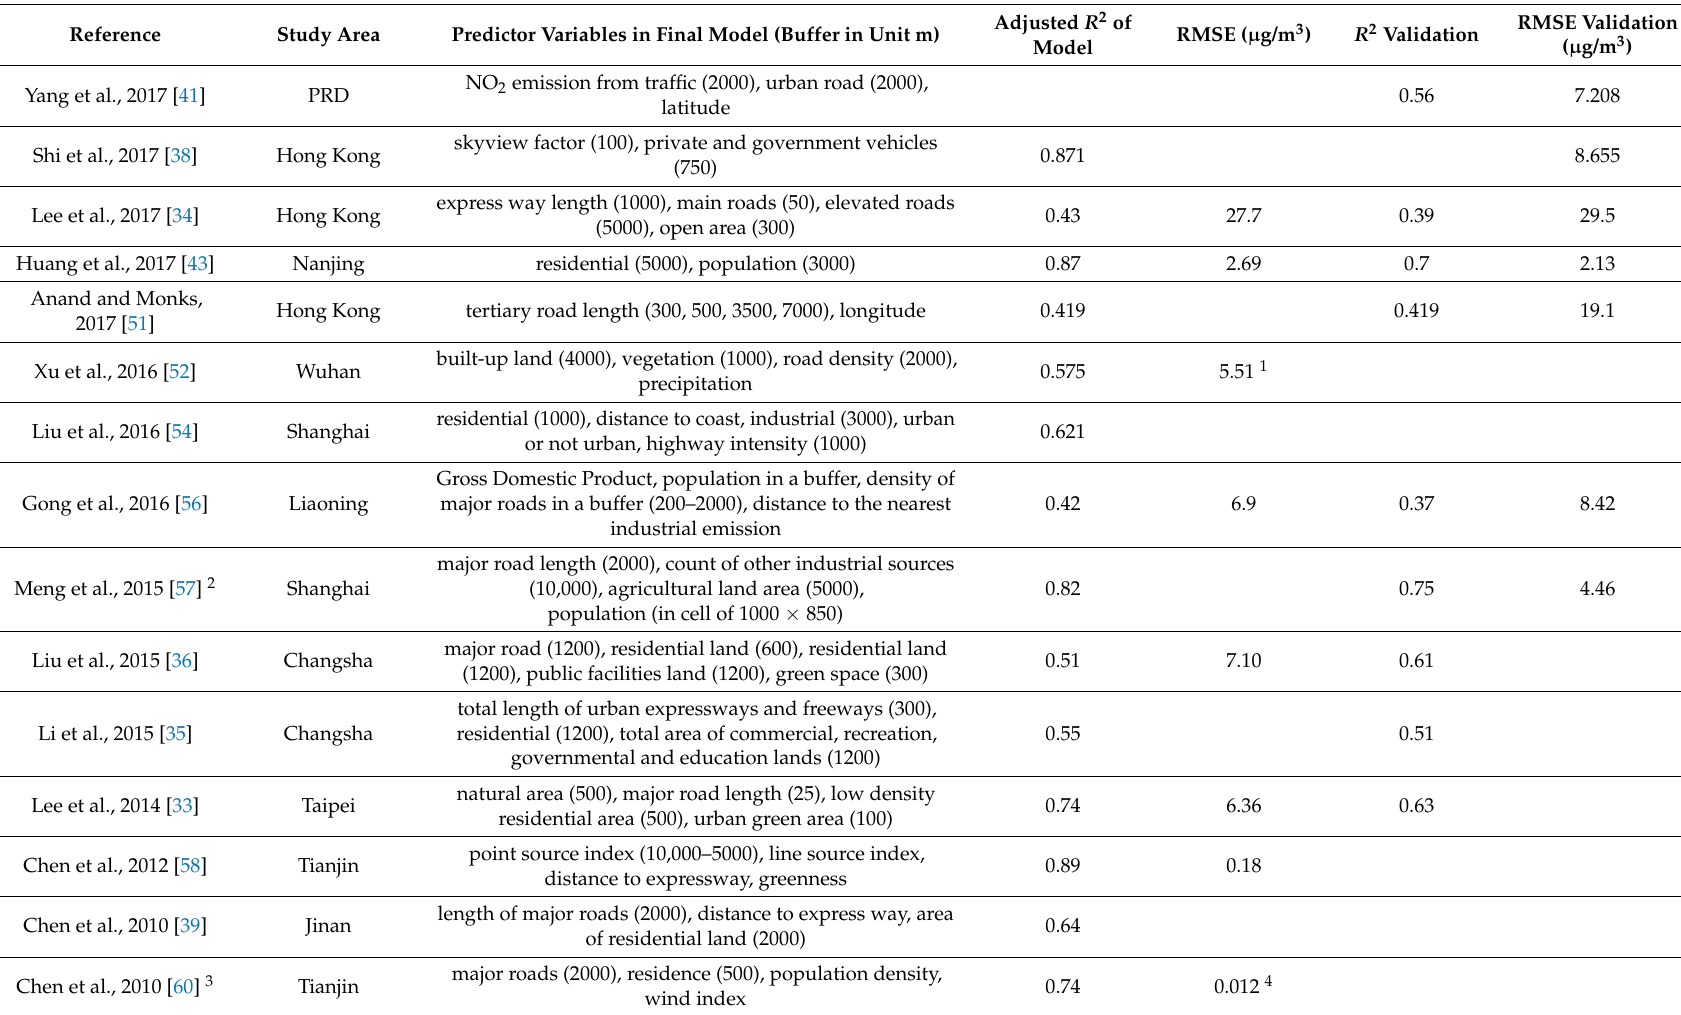
Table 4. Predictor variables and performance statistics of land-use regression models for annual-average NO 2 concentrations in